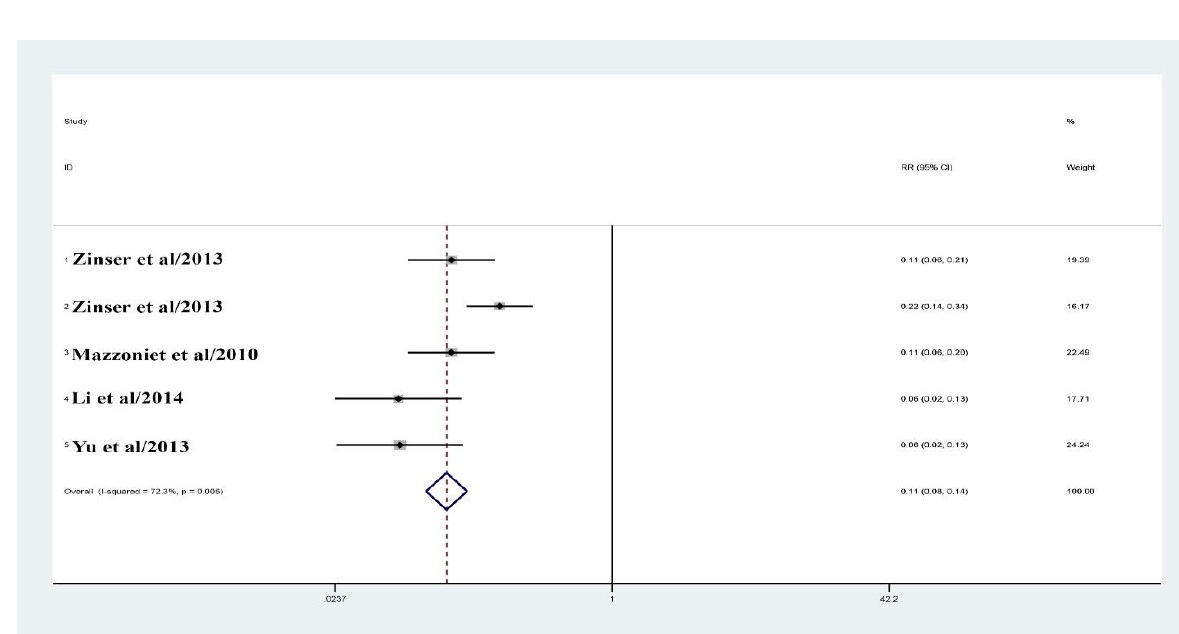
Figure 3. Forest plots with regard to the surgical navigation and ortho-gnathic surgeries. Heterogeneity chi-squared = 14.44 (df. = 4) p=0.006. I-squared (variation in RR attributed to heterogeneity) = 72.3%.